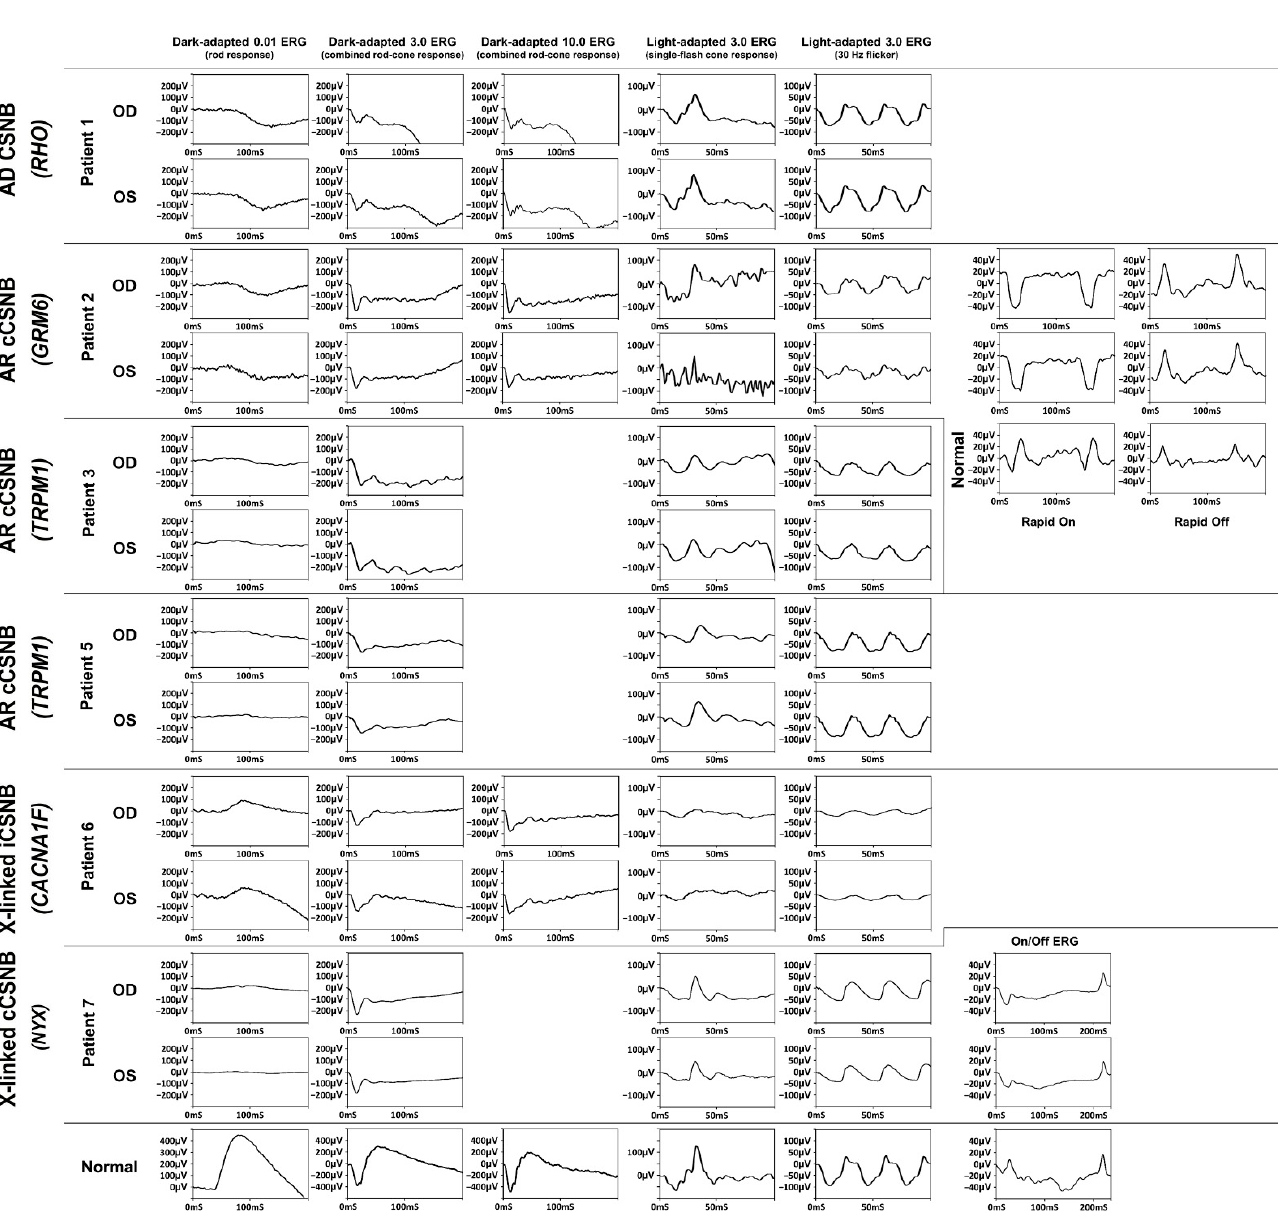
Figure 4. Patients’ full field electroretinogram waveforms.